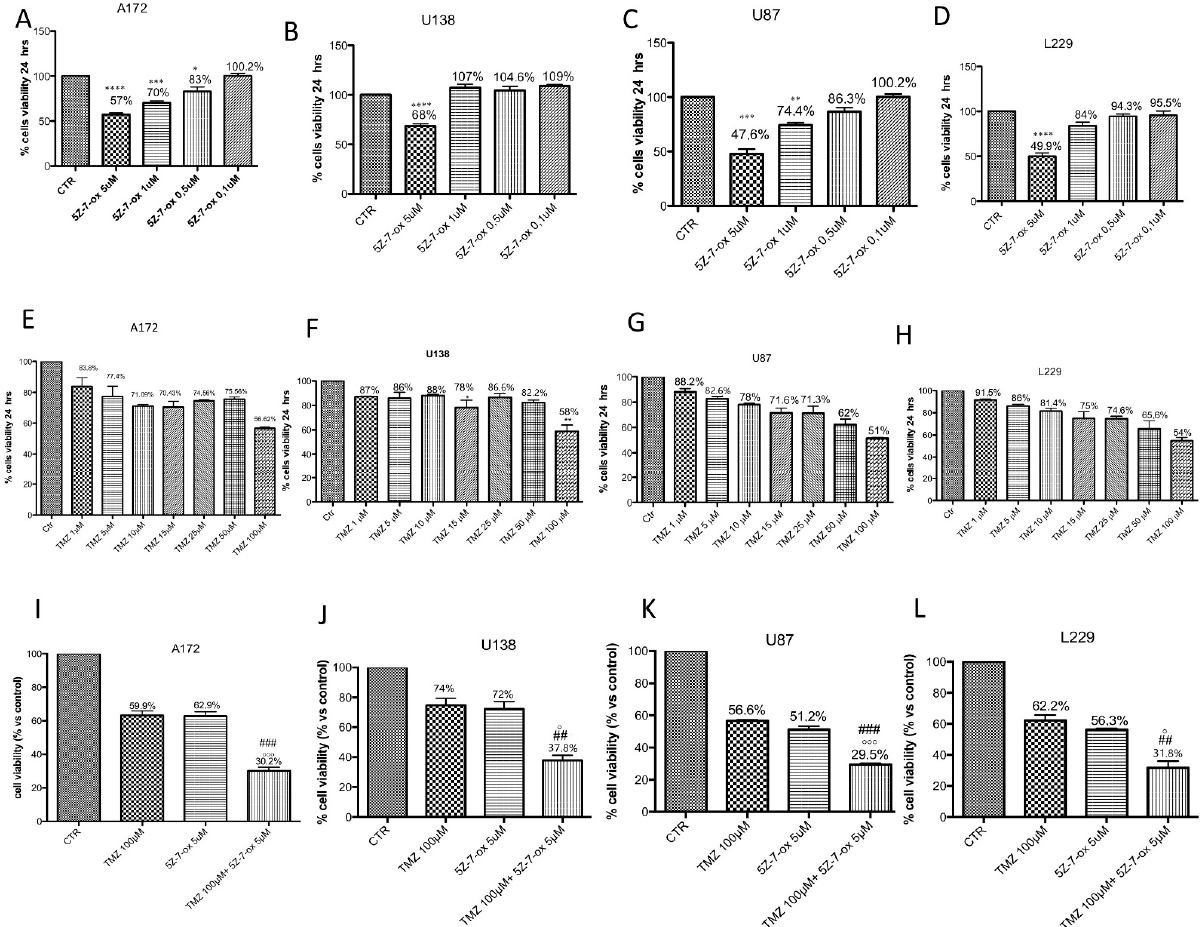
Figure 1. Effect of 5Z-7-ox and temozolomide (TMZ) on survival of glioblastoma cell lines. Cell viability was evaluated using MTT tetrazolium dye and quantified by measurement of optical density at 550 nm (OD550) in glioblastoma cell lines: A172, U138, U87 and L229. Cell death was significantly higher in groups treated with 5Z-7-ox at 5 µ M ( A – D ) and TMZ at 100 µ M ( E – H ) with a mortality percentage at least 50%. ( A ) **** p < 0.0001 vs. control (CTR); *** p < 0.001 vs. CTR; * p < 0.05 vs. CTR. ( B ) **** p < 0.0001 vs. CTR. ( C ) *** p < 0.001 vs. CTR, ** p < 0.01 vs. CTR. ( D ) **** p < 0.0001 vs. CTR. ( F ) ** p < 0.01 vs.